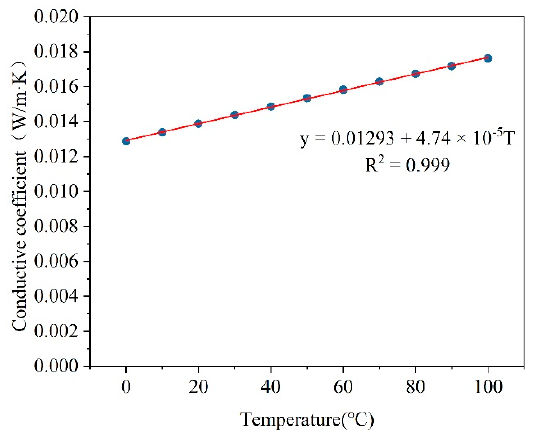
Figure 5. Correlation between vapor conductive coefficient and temperature.